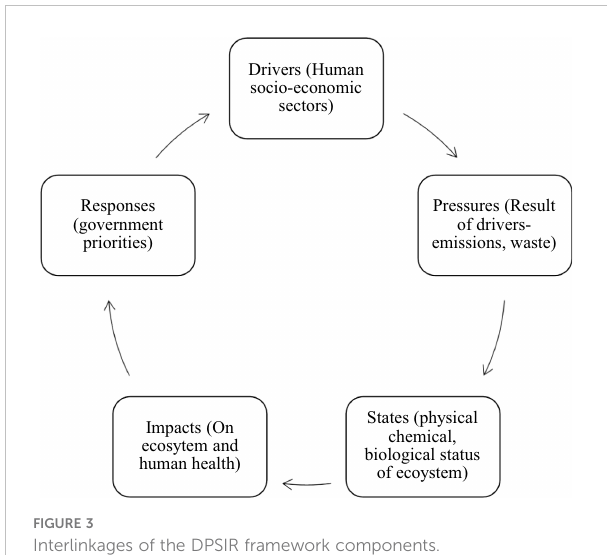
FIGURE 3 Interlinkages of the DPSIR framework components.